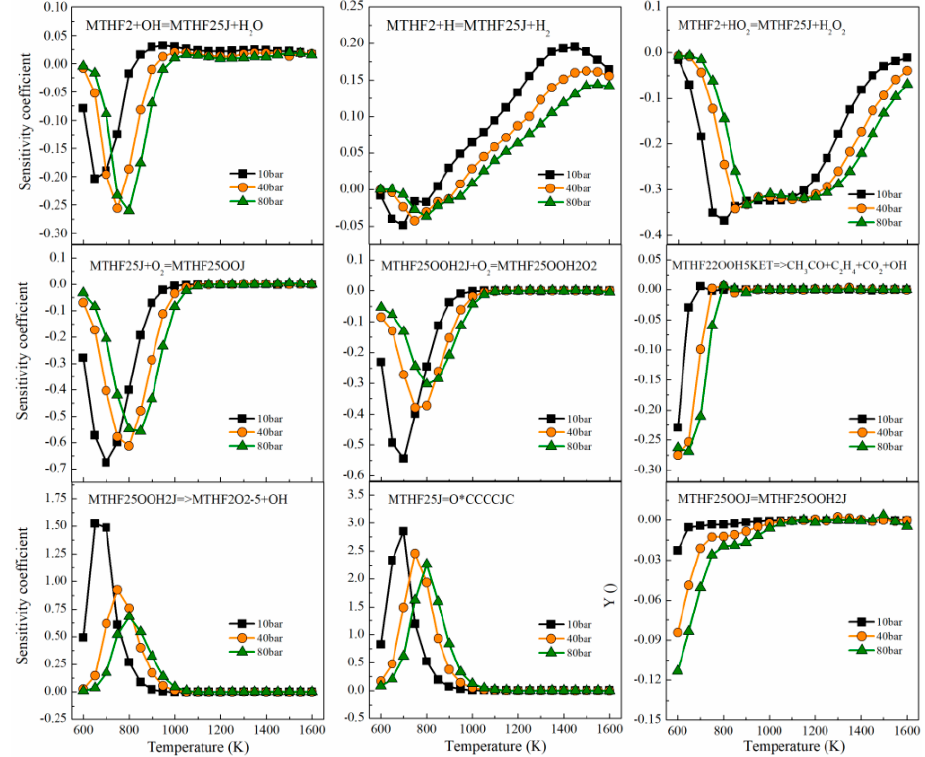
Figure 4. Sensitivity coefficients of ignition delays for reactions involved in the MTHF2 sub-mecha- nism.